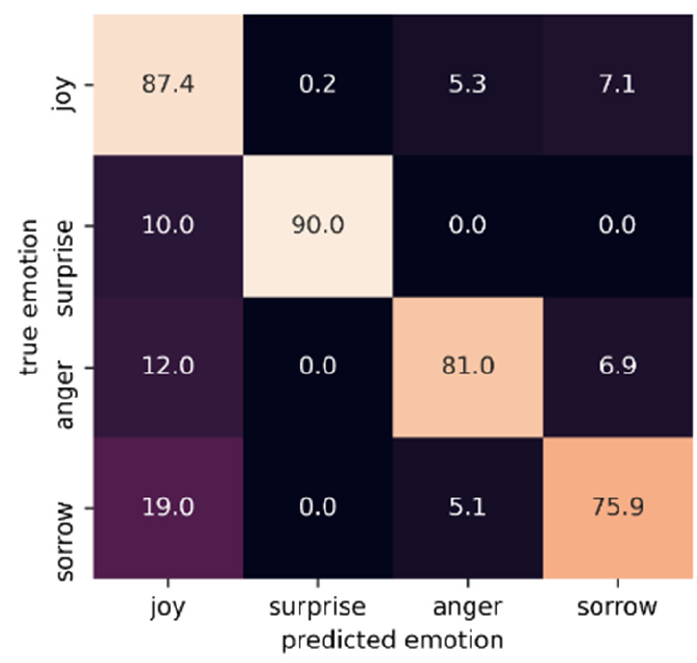
Figure 13. Confusion matrix (dv, hv3, ev).